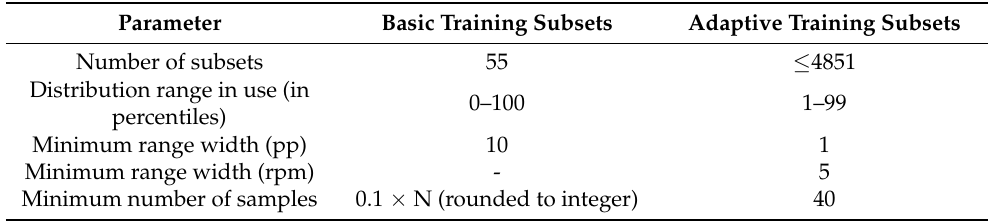
Table 2. Applied parameter values in dataset segmentation approaches. Parameter N is the number of samples in complete training